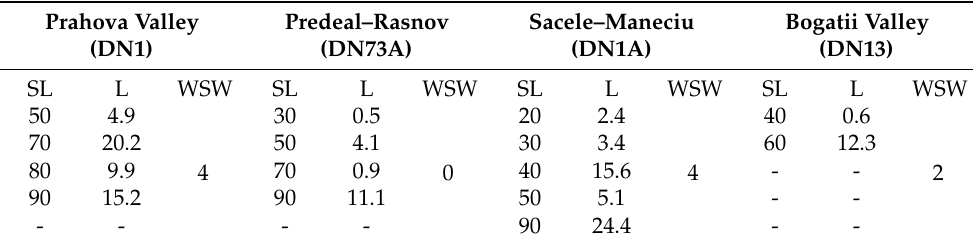
Table 2. Speed limits and wildlife warning signs in the four case